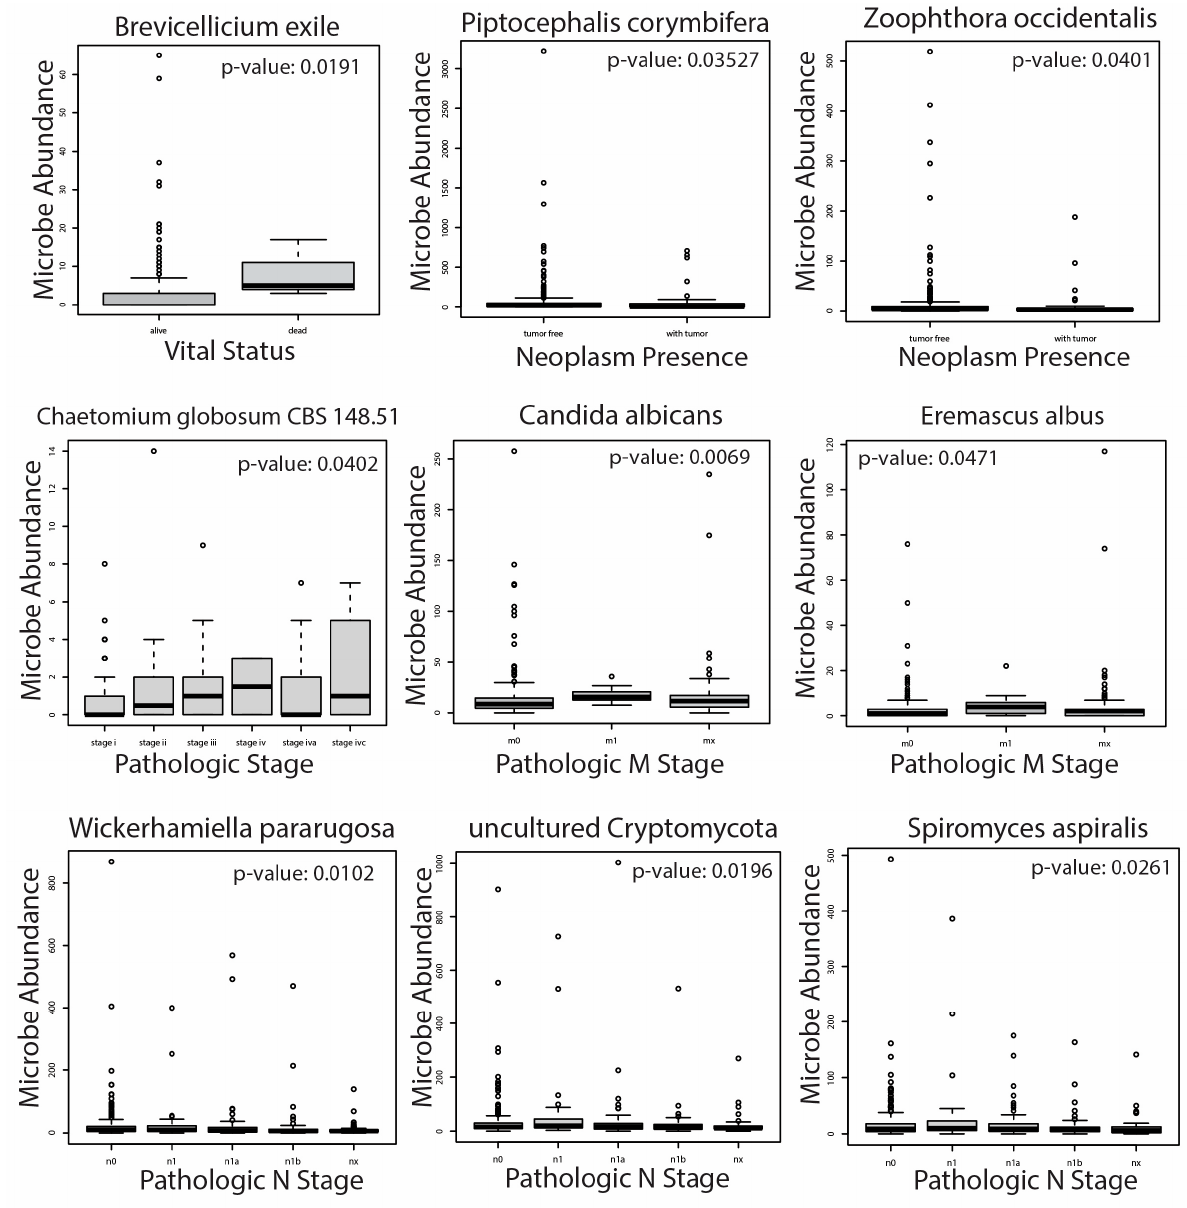
Figure 4. Selected boxplots displaying the correlation of significantly dysregulated microbes in PTC patients (n = 453) with clinical variables pertinent to cancer prognosis and outcomes. We performed clinical variable analysis using the Kruskal–Wallis test ( p -value < 0.05) on fungal and archaeal microbes and following clinical variables: follow-up vital status, perineural invasion, pathologic stage, and cancer T, N, and M staging. In total, we found 26 microbes were significantly correlated with these clinical variables (Supplementary File S3), all of which were fungal species.